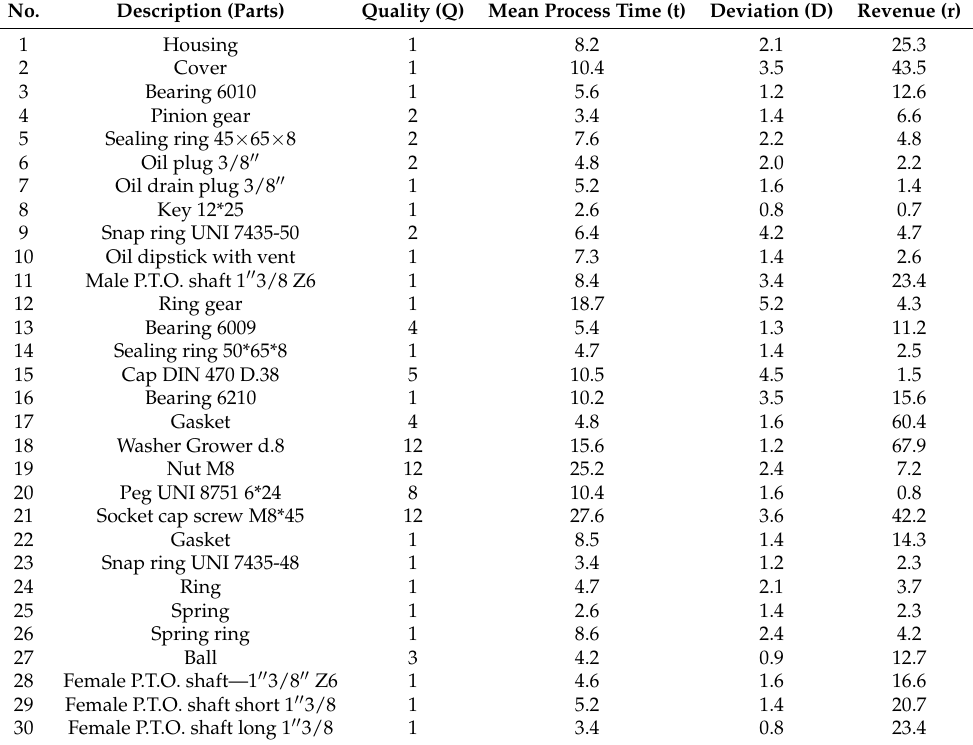
Table A1. Bill of materials of Splitter Gearboxes Series 85000.